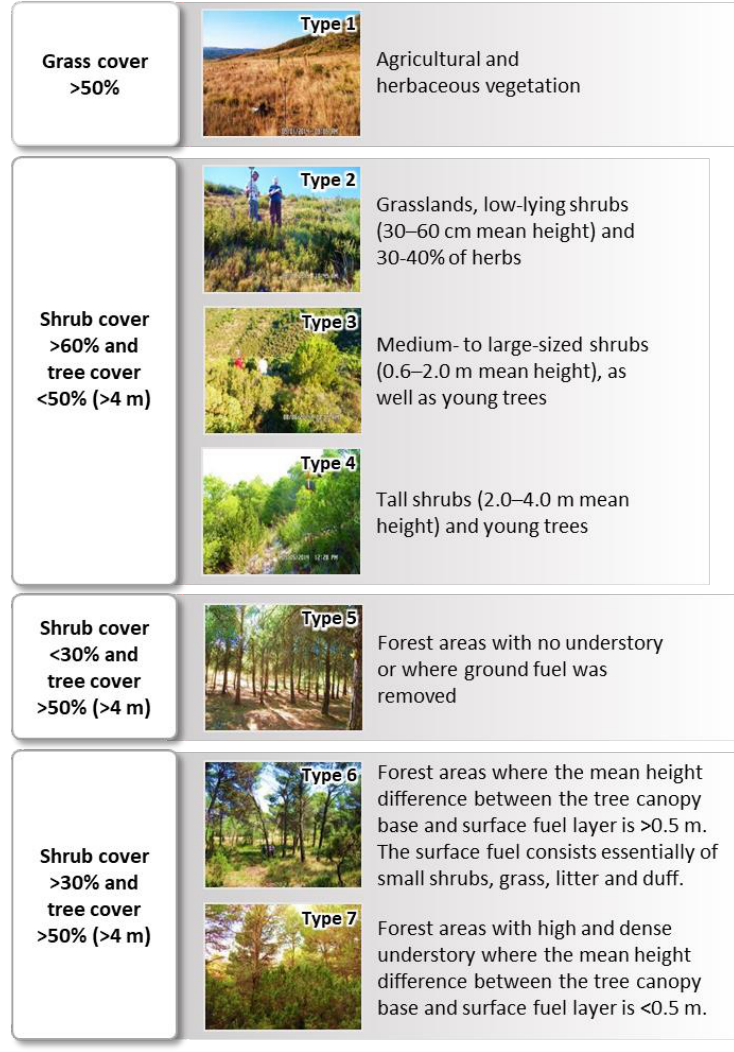
Figure 2. Prometheus fuel types. Photographs taken by Col. Escribano and A.